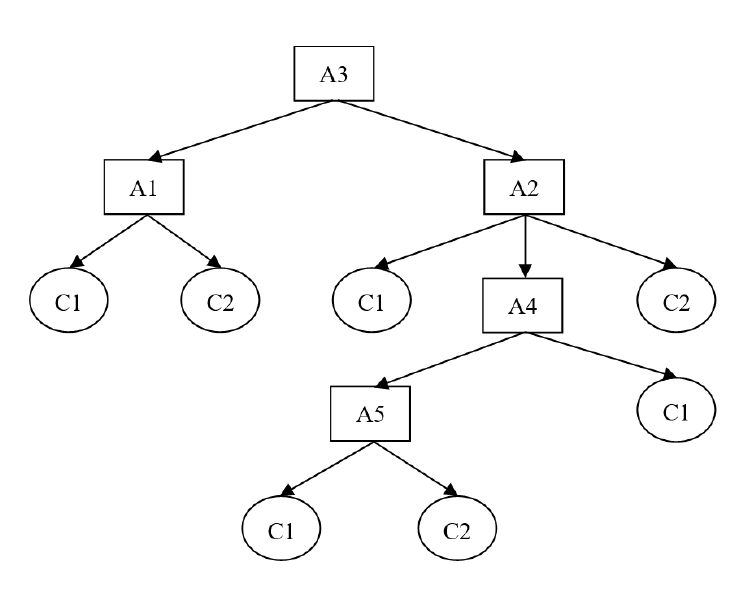
Fig. 5 Decision Tree Generated by Defect